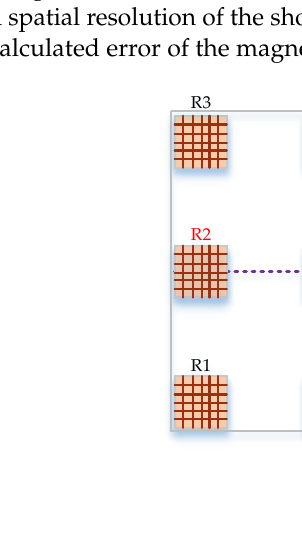
Figure 6. ( a ) Schematic diagram of four-coil tensor position; ( b ) schematic diagram of five-coil tensor position.